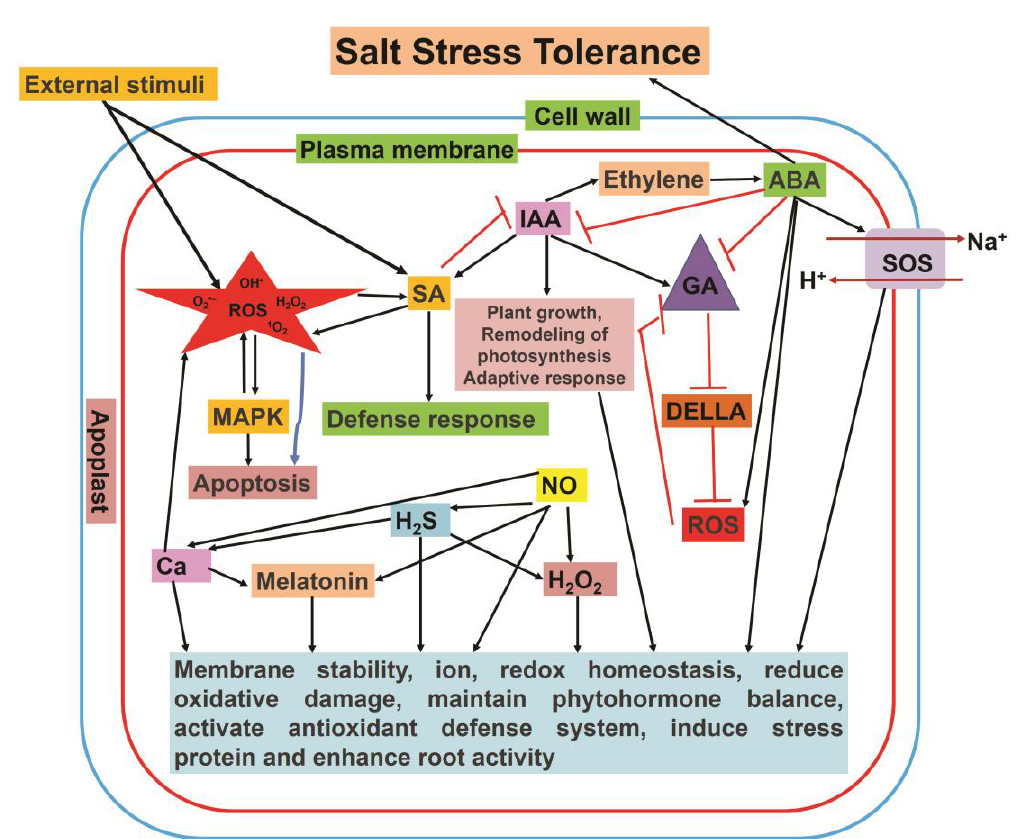
Figure 5. Overview of crosstalk between the different signaling molecules and phytohormones during salt stress tolerance. ROS, reactive oxygen species; O 2 •− , superoxide anion; 1 O 2 , singlet oxygen; HO•, hydroxyl radical; H 2 O 2 , hydrogen peroxide; NO, nitric oxide; H 2 S, hydrogen sulfide; Ca, calcium; SA, salicylic acid; GA, gibberellins; IAA, indole acetic acid; ABA, abscisic acid; SOS, salt overly sensitive; MAPK, mitogen-activated kinase protein.